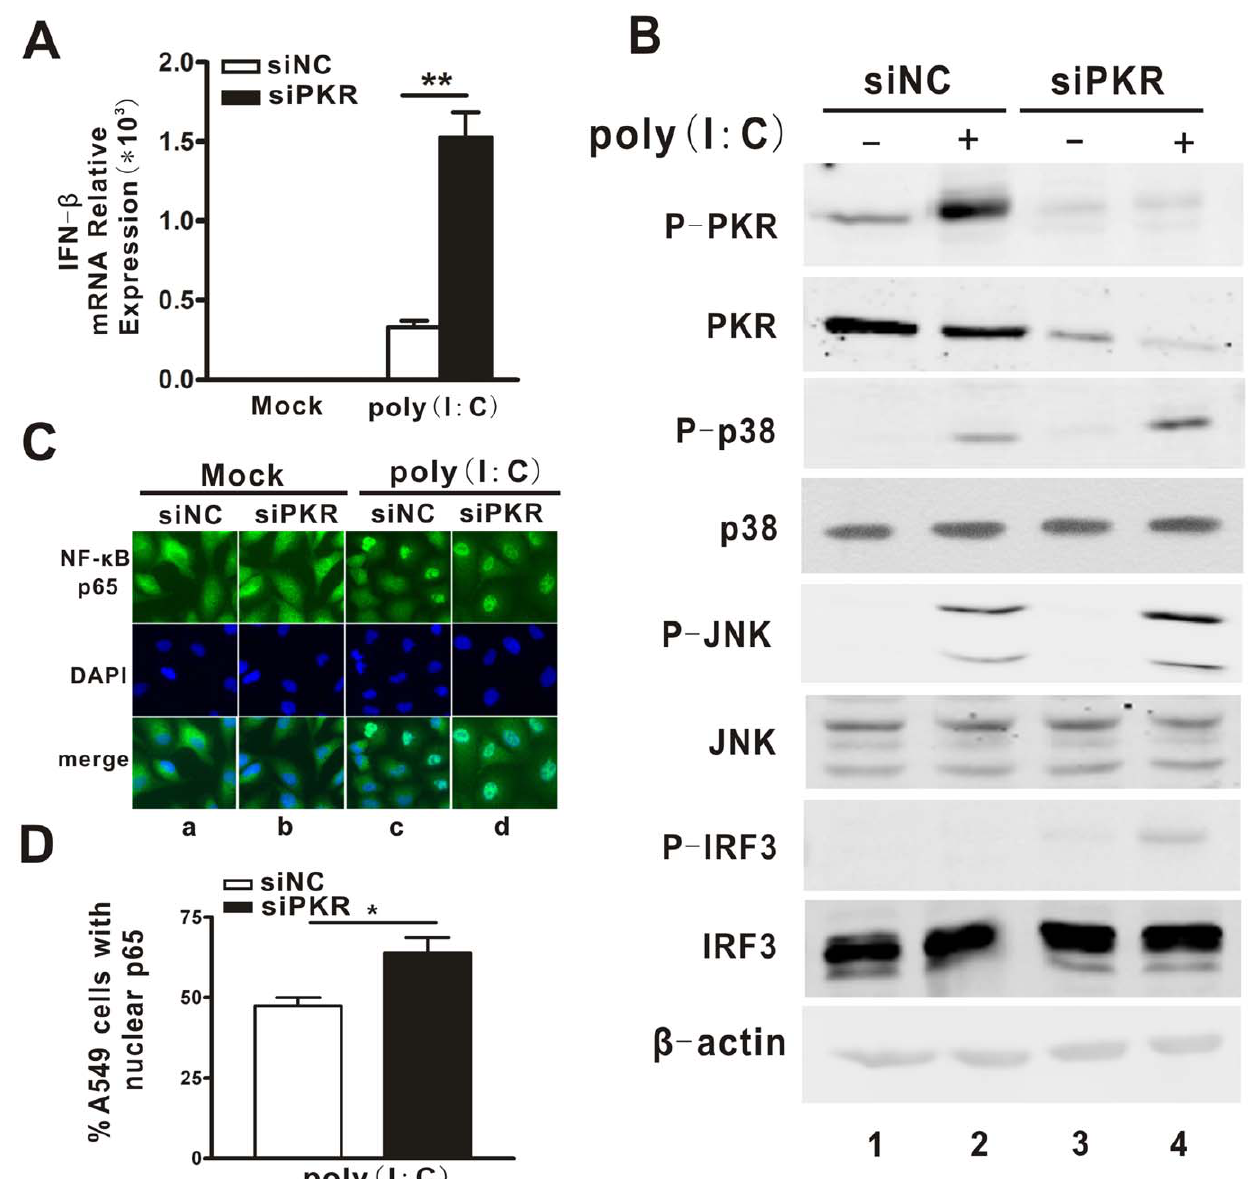
Figure 6. PKR knockdown enhanced IFN expression and activation of MAPKs, IRF3 and NF- k B pathways induced by poly(I:C). A549 cells were transfected with siPKR1 or siNC for 48 h, and then transfected with poly(I:C) for 1 h. Expression levels of IFN- b (A) were tested by real-time PCR and normalized to GAPDH. Phosphorylation form and total protein of p38 and JNK MAPKs, IRF3 and PKR were detected by Western blot (B). Immunoflurescence microscopy images to show subcellular localization of NF- k B p65 (C). PicCnt 100x was used to determine the percentages of cells stained with nuclei NF- k B (D). Data are shown as mean 6 SEM for at least three independent experiments. *p , 0.05,**p , 0.01.